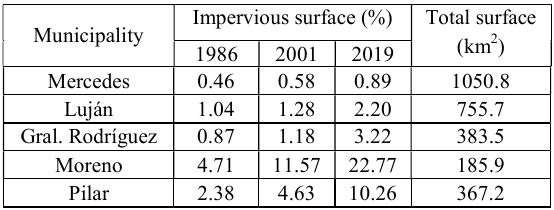
Table 1. Impervious surface in urban areas per year